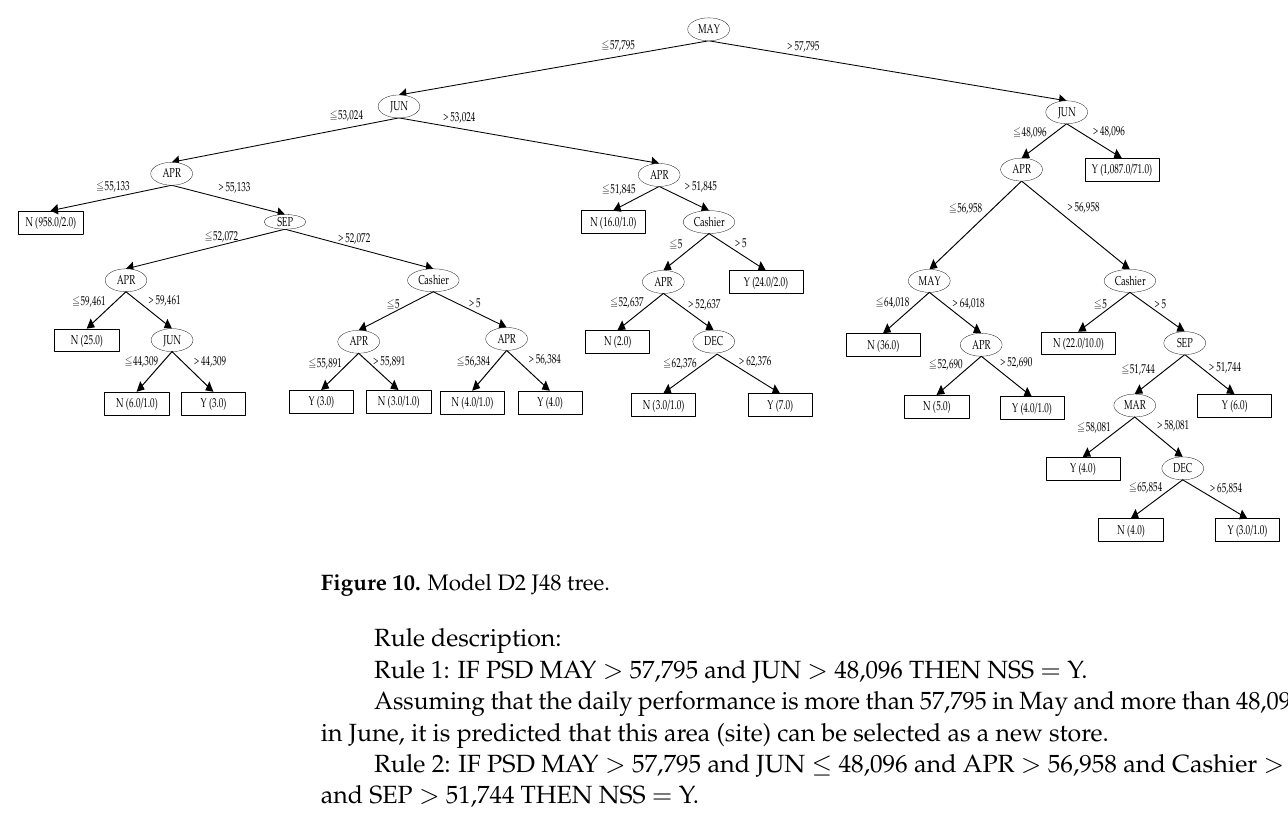
Figure 10. Model D2 J48 tree.